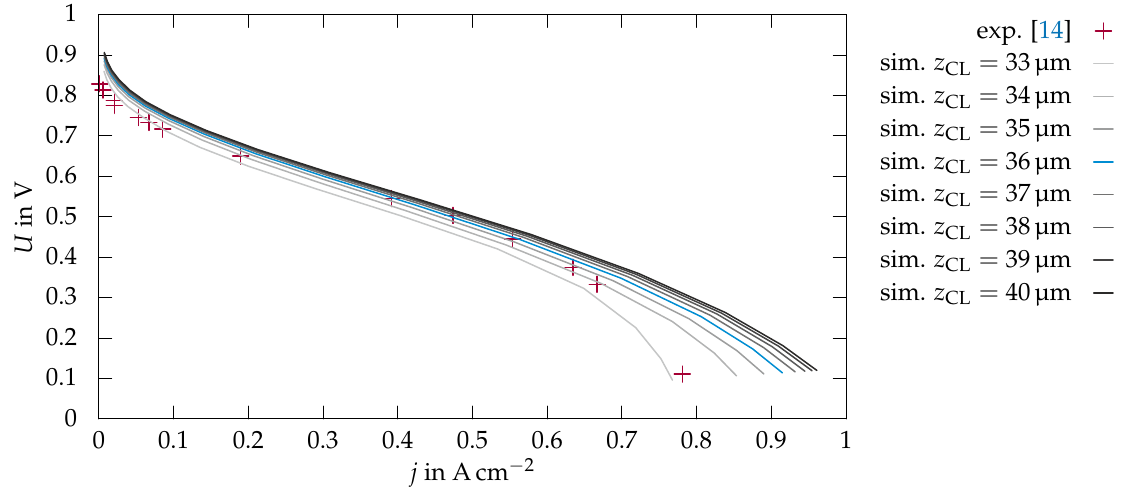
Figure 8. Polarisation curves for the parameter variation of z CL = 33–40µm with a constant median value for PtE =